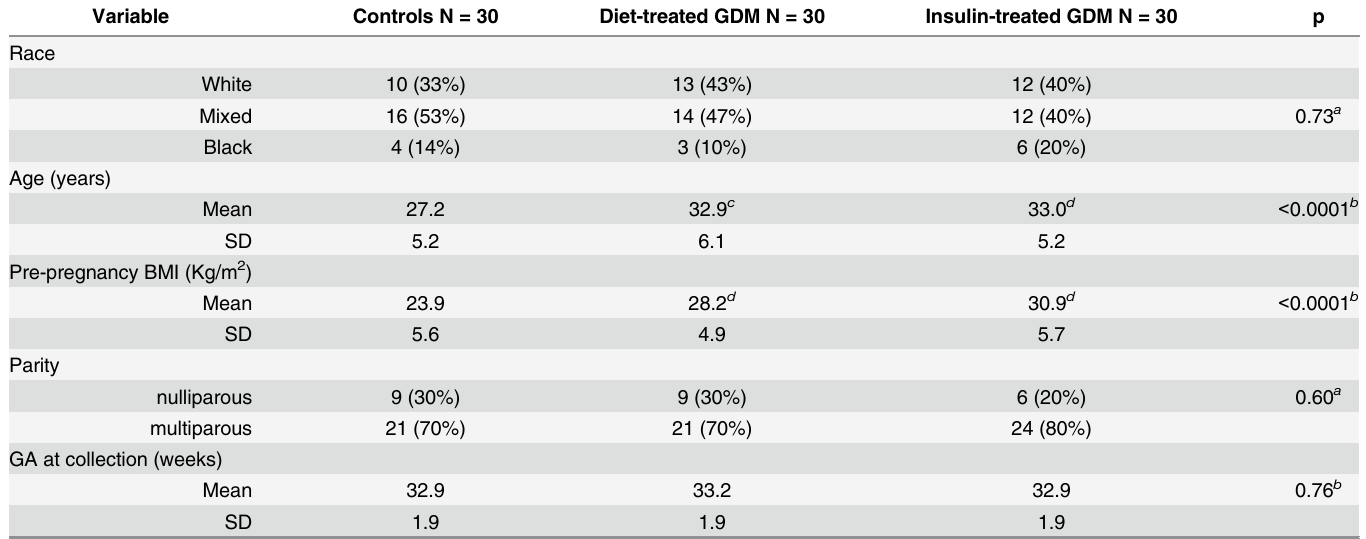
Table 1. Main characteristics of 90 pregnant